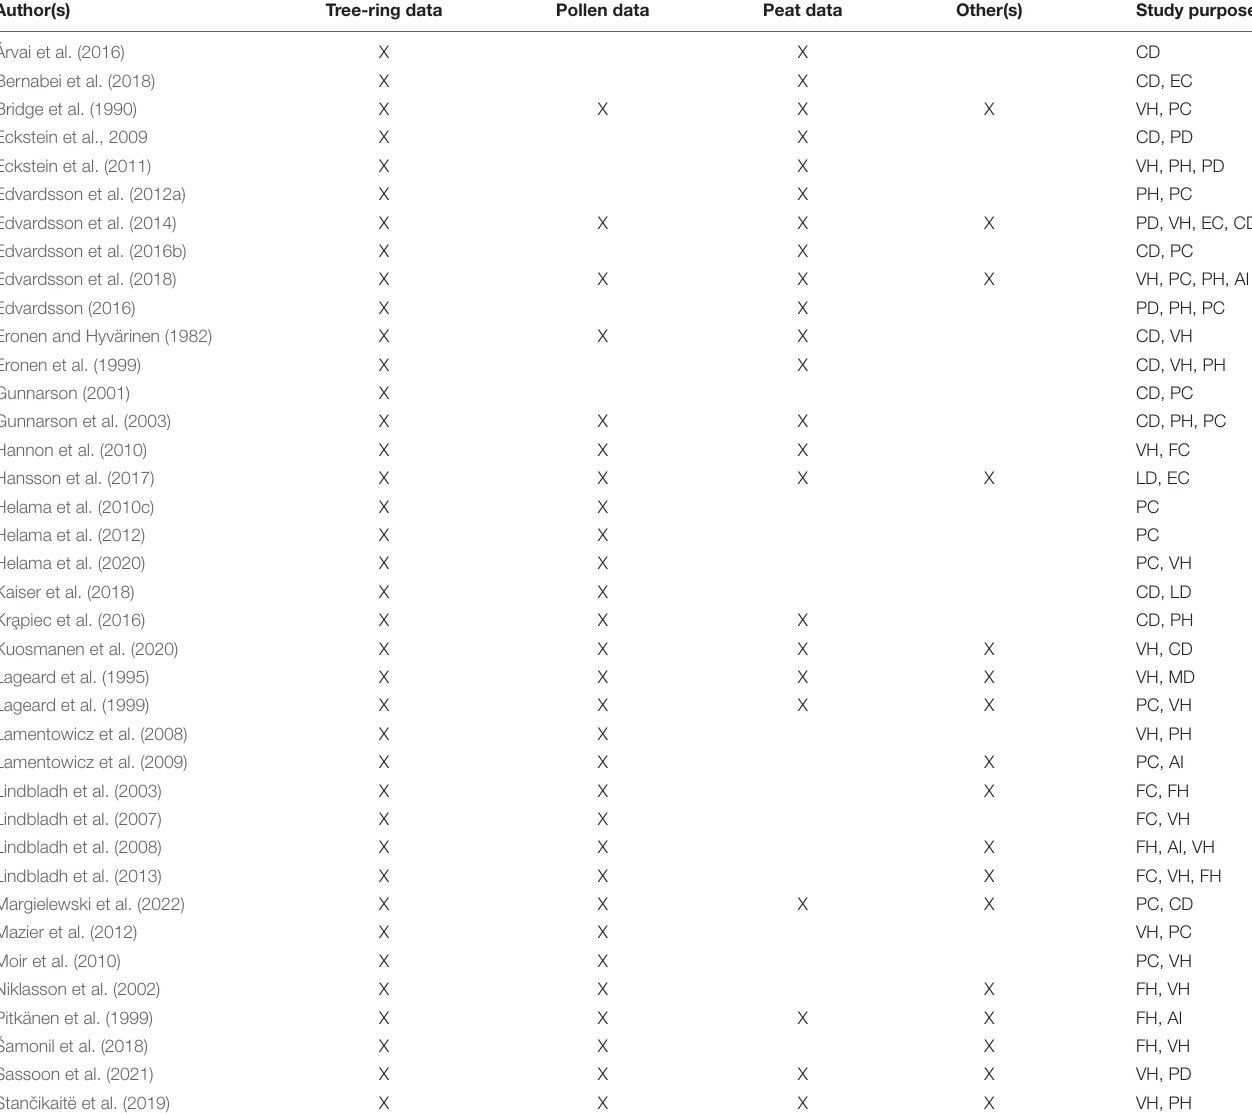
TABLE 1 | Multi-proxy studies including tree-ring data (dendrochronology) in combination with stratigraphic proxy data including pollen data, peat stratigraphic data (e.g., content and degree of humification), and other(s) stratigraphic proxy data (e.g., plant macrofossil, charcoal, and testate